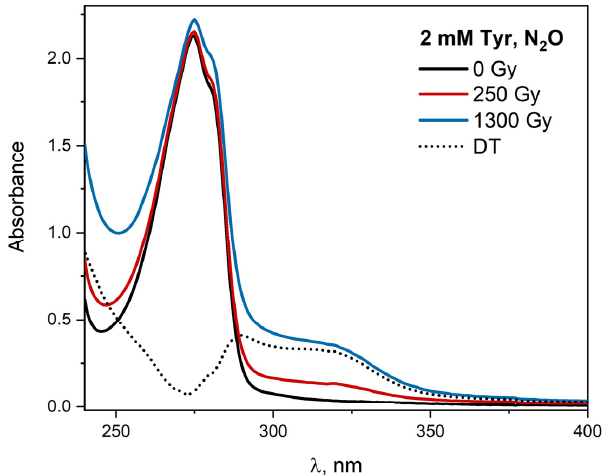
Figure 11. Absorption spectra of N 2 O-saturated buffer solution of Tyr (2 mM), obtained for irradiation doses between 0 and 1300 Gy.